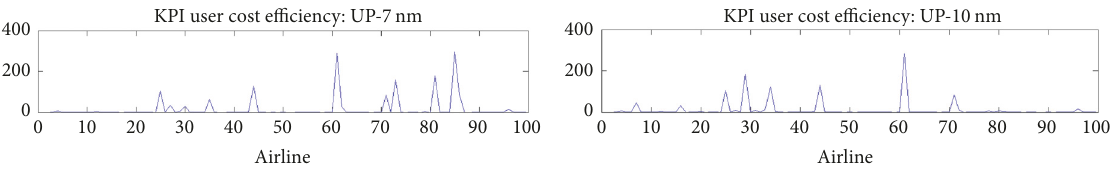
Figure 13: User cost efficiency (Kg/flight) in analysis cases 7 NM/100-AUs/CI in [0,10000] versus 10NM/100-AUs/CI in [0,10000] . Table 5: Variation in fairness and equity among flights with different versions of the algorithm and different CI allocations. Analysis